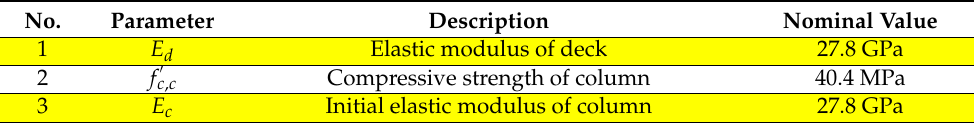
Figure 6. Schematic representation of the SRC bridge FE model. The parameter numbers in the parentheses are listed in Table 2. Table 2. Candidate unknown model parameters. The model parameters are linked to their associated model components in Figure 6. The unknown parameters to be estimated using the model updating technique are highlighted in this